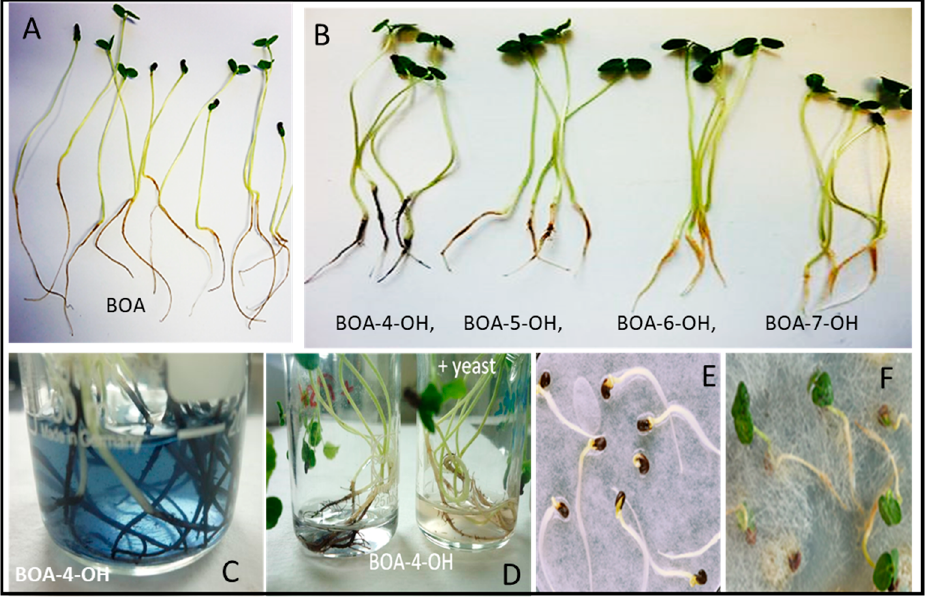
Figure 2. ( A ): Seedlings after 24 h BOA incubation, leaves are not impaired. ( B ): Incubations of seedlings with the four BOA-OH isomers. Seedlings are shown after the incubation: Only BOA-4-OH led to roots covered with a bluish-black polymer. ( C ): Roots exposed to BOA-4-OH during incubation. ( D ): Addition of the yeast Papiliotrema baii , a member of the Actinomucor elegans consortium, prevents polymer covers on the root surfaces. ( E ): A. elegans consortium has no damaging effects on germinating velvetleaf. ( F ): Healthy velvetleaf seedlings are cocooned by A. elegans hyphae. Isolated P. ananatis and the entire consortium, but not the isolated yeast, are able to nitrate the plant-produced detoxification intermediate BOA-6-OH, resulting in 6-hydroxy-5-nitrobenzo[ d ]oxazol-2(3 H )-one (NO2-BOA-6-OH). In contrast, P. baii formed only a dimer of BOA-6-OH [90,96]. NO2-BOA-6-OH was produced by velvetleaf root surface proteins and was also identified in the incubation media of velvetleaf when supplemented with BOA-6-OH. This nitroaromatic compound in concentrations of 8 to 86 µ M enhanced A. theophrasti root growth at pH 5 but had no effect on shoot growth. The I 50 value was 300 µ M for root growth at pH 5 and 700 µ M for shoot growth at pH range of 4 to 6. Velvetleaf root surface proteins that included microbial sources were able to reduce NO2-BOA-6-OH up to 90% when assayed in vitro with the compound. In contrast, Lepidium sativum (L.) root and shoot growth was inhibited by 50% and 90%, respectively, with 86 µ M NO2-BOA-6-OH